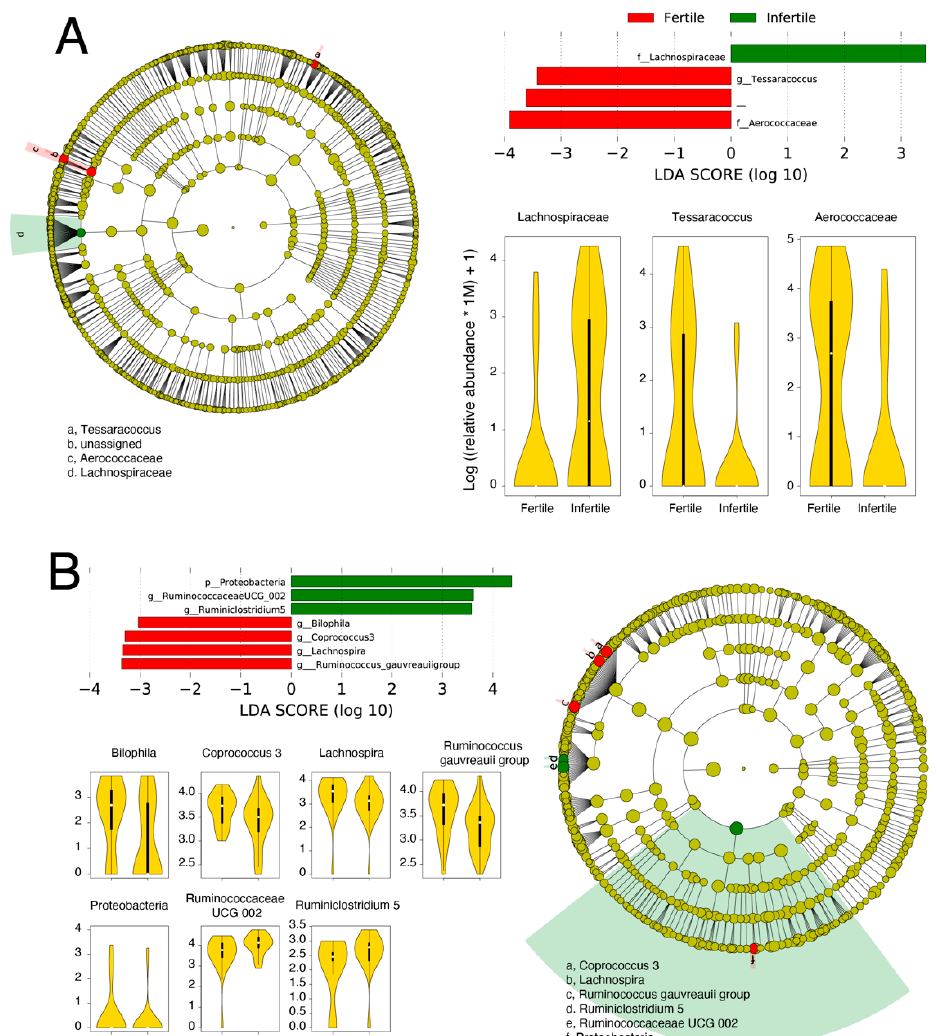
Figure 4. Biomarker discovery in the genital ( A ) and gut ( B ) samples. Microbial taxa differentially abundant between fertile and infertile genital and gut samples are named along with their LDA scores, cladograms, and relative abundance distributions.